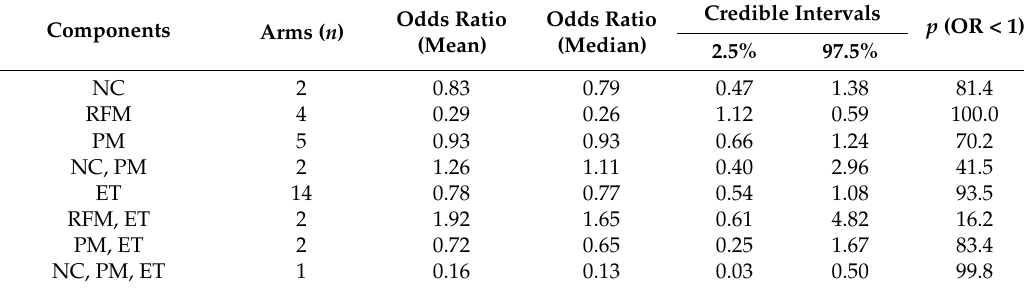
Table 4. Odds Ratio Point Estimates for Core Component Combinations in Comparison to Usual Care, for Full Interaction Model for Revascularization